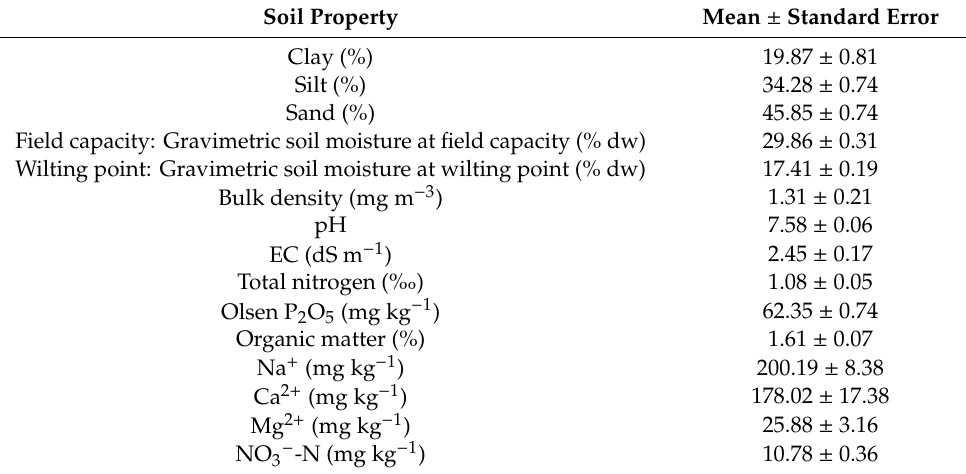
Table A2. Main physico-chemical properties of the 0.7 m soil